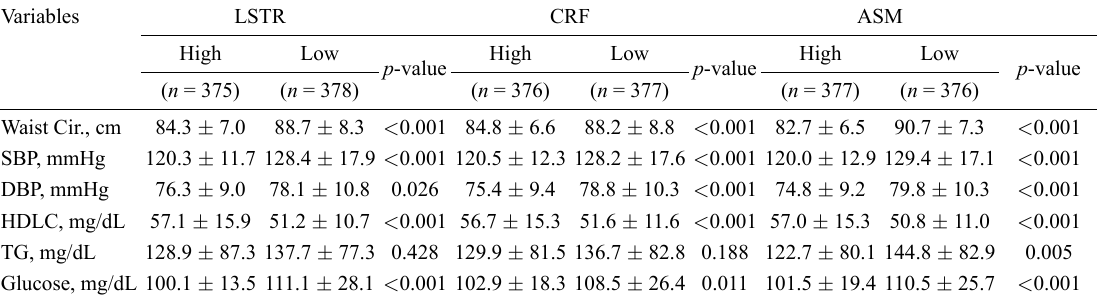
Table 2. Men’s metabolic syndrome factors based on relative values of variables. Variables